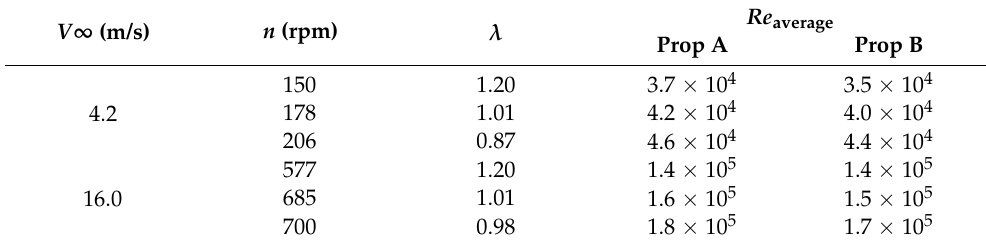
Figure 27. Results of the repeated test: ( a ) Thrust coefficient vs. advance ratio; ( b ) Power coefficient vs. advance ratio. Table 6. Comparison between two optimized propellers at the design